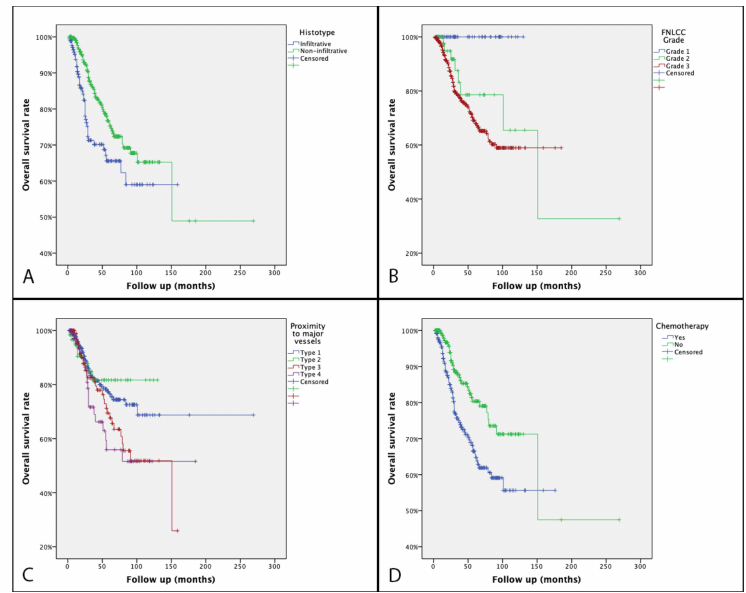
Figure 3. Kaplan–Meier overall survival curve according to histotype ( A ), FNLCC grade ( B ), proxim- ity to major vessels ( C ), and chemotherapy ( D